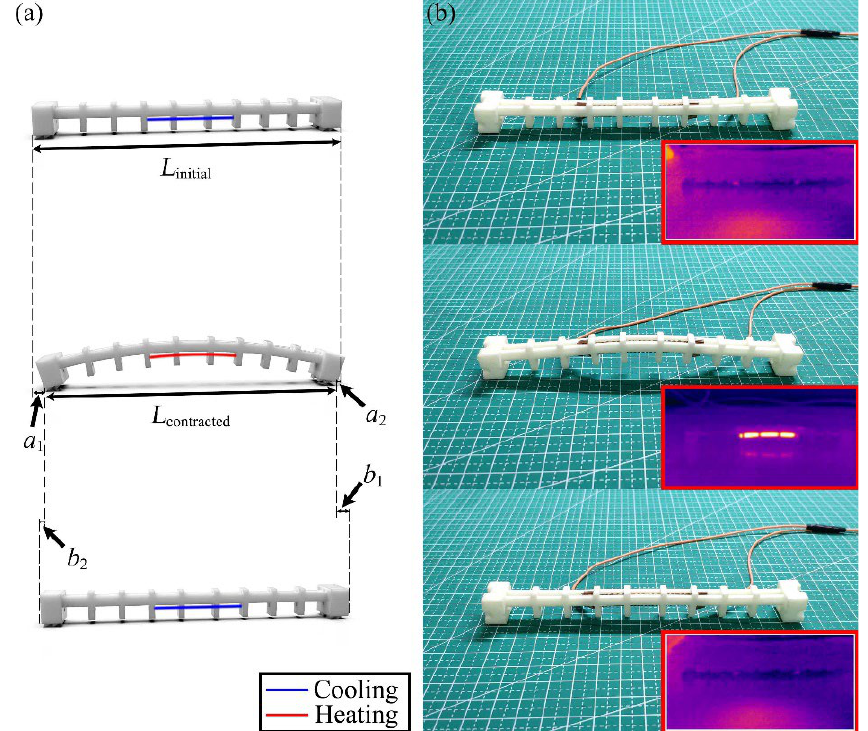
Figure 8. Locomotion efficiency analysis of the crawling robot. ( a ) Schematic diagram during one locomotion cycle of the crawling robot. The robot moves forward a short distance, accompanied by a slide. ( b ) The actual locomotion cycle and infrared thermograms during the locomotion of the crawling robot.